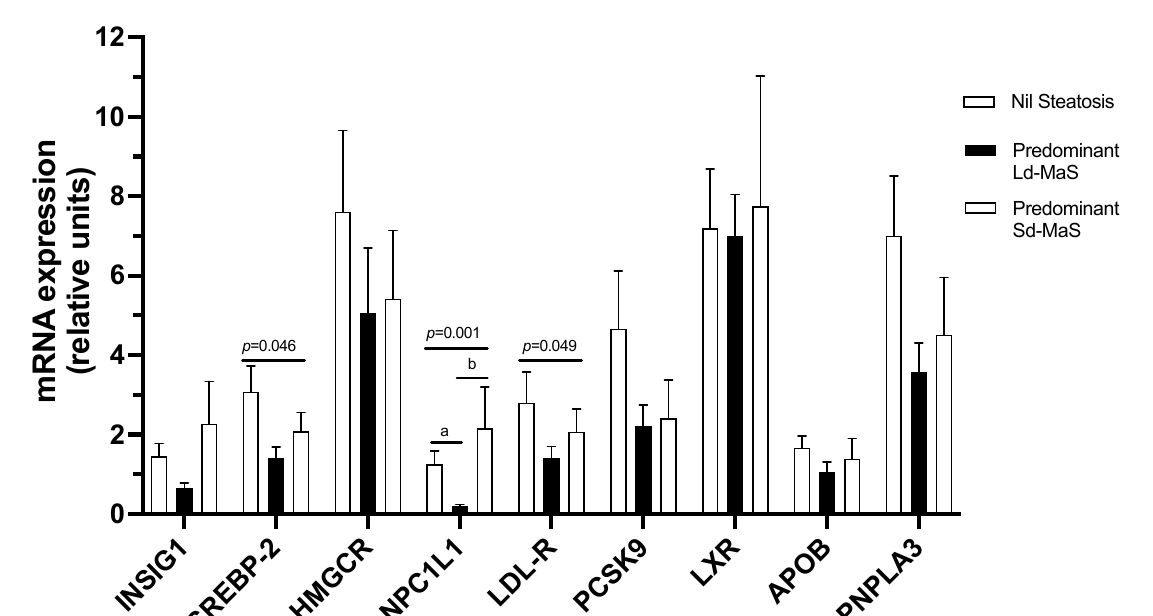
Figure 2. Univariate analyses of liver graft mRNA gene expression of selected proteins involved in lipid metabolism according to the presence and the predominant type of steatosis. The 9 genes are listed on the x-axis, and the fold change of expression is shown on the y-axis. Data are expressed as mean ± SE. p -Values refer to overall significance among the 3 groups using the Kruskal–Wallis test; a: p < 0.005 at post hoc Dunn analysis with Bonferroni correction for multiple comparisons between predominant Ld-MaS and nil-S groups; b: p < 0.02 at post hoc Dunn analysis with Bonferroni correction for multiple comparisons between predominant Ld-MaS and predominant Sd-MaS groups. APOB: apolipoprotein B; PNPLA3: Patatin-like phospholipase domain protein 3; HMGCR: 3-hydroxyl-3-methylglutaryl coenzyme A reductase; INSIG-1: insulin-induced gene 1; LDLR: LDL receptor; LXR: Liver X receptor; NPC1L1: Niemann-Pick C1-Like 1; PCSK9: Proprotein convertase subtilisin/kexin type 9; SREBP-2: sterol regulatory element-binding protein 2.